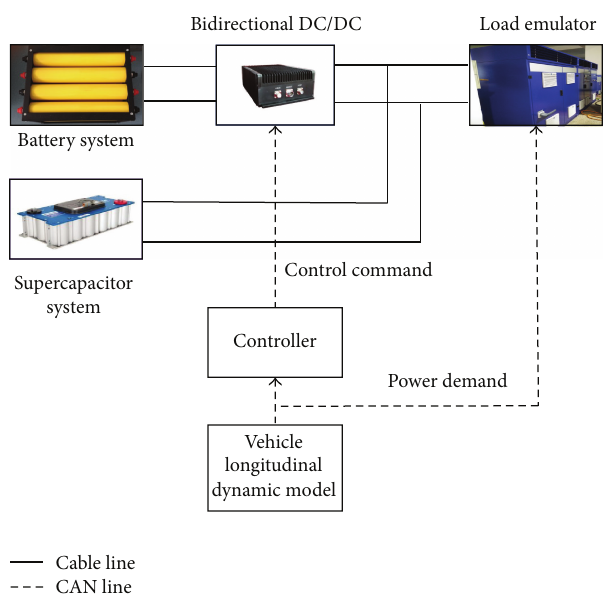
Figure 3: A semiactive topological